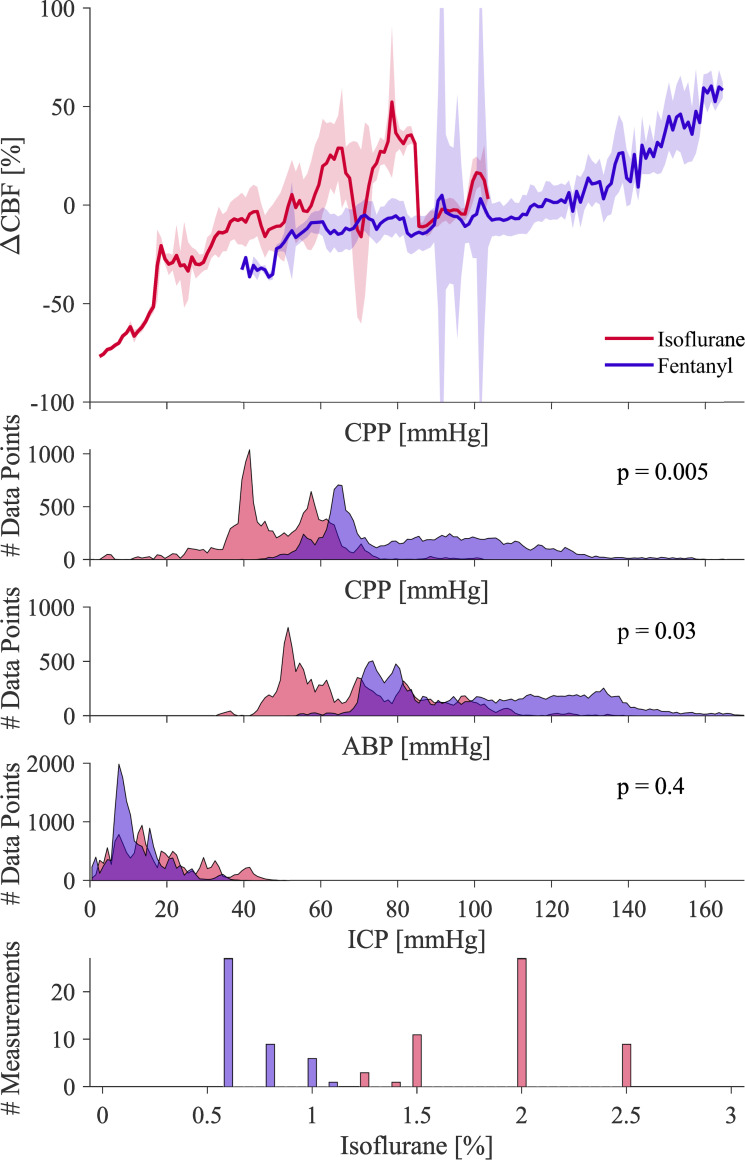
Lassen’s curve shows the relationship of ΔCBF over CPP (top) as a function of anesthetic.Here the red line indicates isoflurane anesthesia, and the blue line represents the group with mainly fentanyl anesthesia. Shaded areas show the standard deviation across all NHPs in this group. The histograms are based on group averaged data for CPP, ABP, and ICP (from the top), with histogram bin sizes of 1 mmHg. A Mann-Whitney U-test was performed to test statistical significance between fentanyl and isoflurane groups. The bottom graph shows the distribution of isoflurane percentage for the anesthetic groups with the number of measurements (of approx. one-hour length each). Isoflurane percentages were recorded manually every 15 minutes, and an average across one recording (approx. 90 minutes of unchanged ICP baseline) was calculated.